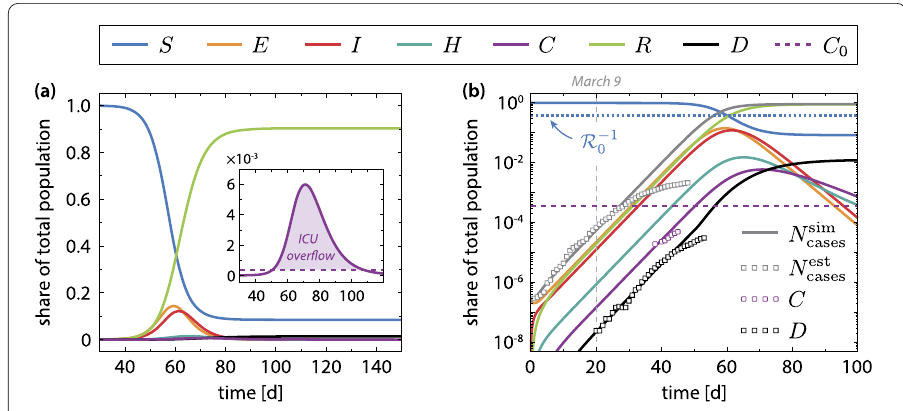
Figure 2 ( a ) Evolution of the epidemic without interventions ( u = 1). The number of available ICUs was set to C 0 = 30,000. The inset shows the overflow in ICU demand, which leads during a period of about 57 days to an increased mortality rate according to Eq. (4a)–(4b). ( b ) Same as in ( a ) but on a logarithmic scale. The markers indicate the estimated number of cumulative cases (see Appendix C) and the reported numbers for ICU demand and deaths during the early phase of the COVID-19 pandemic in Germany. The first disease-related fatalities were reported on March 9, 2020 (day number 20 in the simulation). Social distancing measures, which came into force nationwide in mid-March [16], have flattened the initial exponential